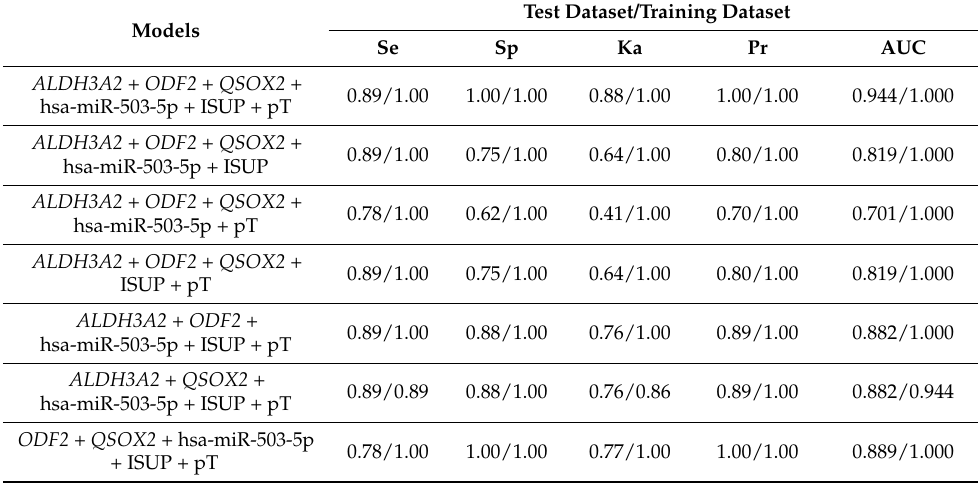
Figure 6. ROC-curve of predictive models of test dataset. The ALDH3A2 + ODF2 + QSOX2 + hsa- miR-503-5p + ISUP + pT model is colored in green; the models with a predictor omitted are shown in gray shades. AUC—area under the error curve. Table 5. Metrics of predictive models. Se—sensitivity, Sp—specificity, Ka—kappa (normalized proportion of correct answers), Pr—precision, AUC—area under the error